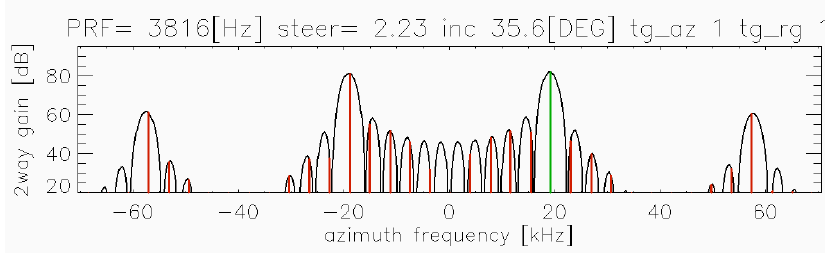
Figure 5. Azimuth pattern steered to 2.2°. Azimuth frequency corresponding to the direction towards the scene center (green) and ambiguous frequencies (red).